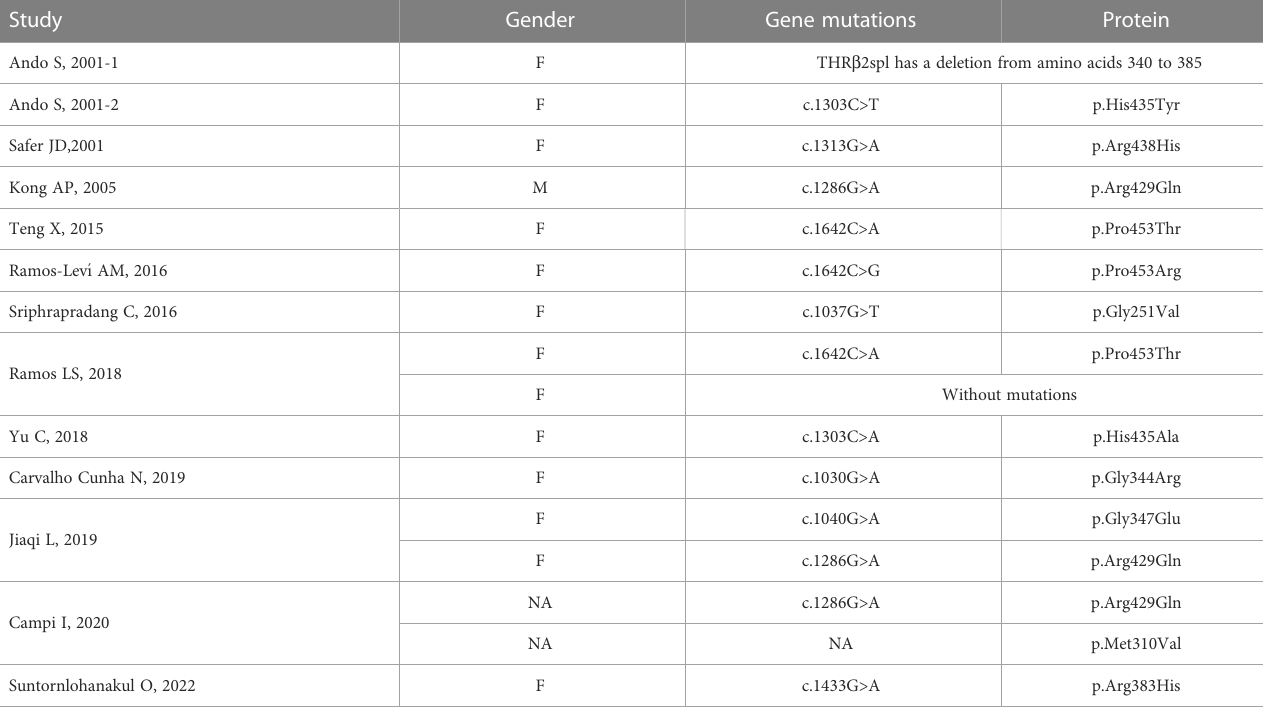
TABLE 2 Summary of the THR b mutations of RTH patients coexistent with pituitary